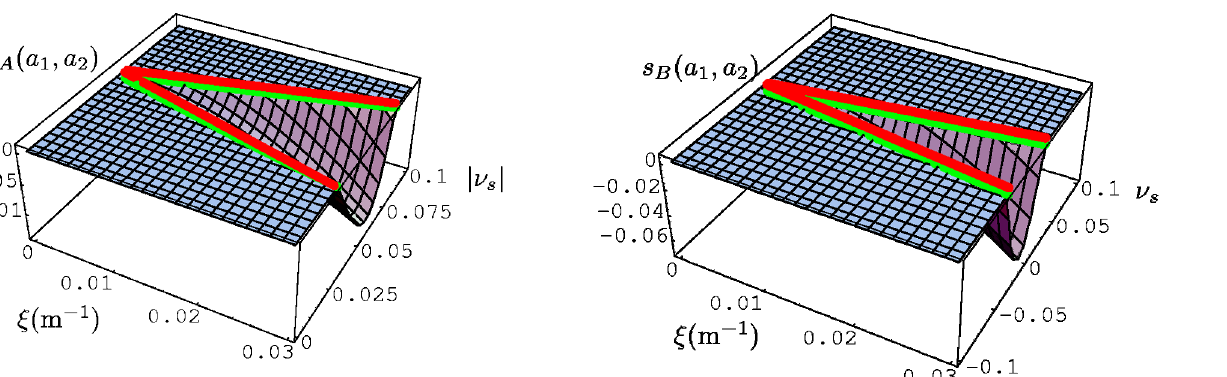
FIG. 9. (Color) Unstable region caused by two crab cavities, (cid:20) apart in betatron phase for (cid:28) (cid:2) 8 : 51 . Light green: border of stability; dark red: border of stability from the approximate Eq.